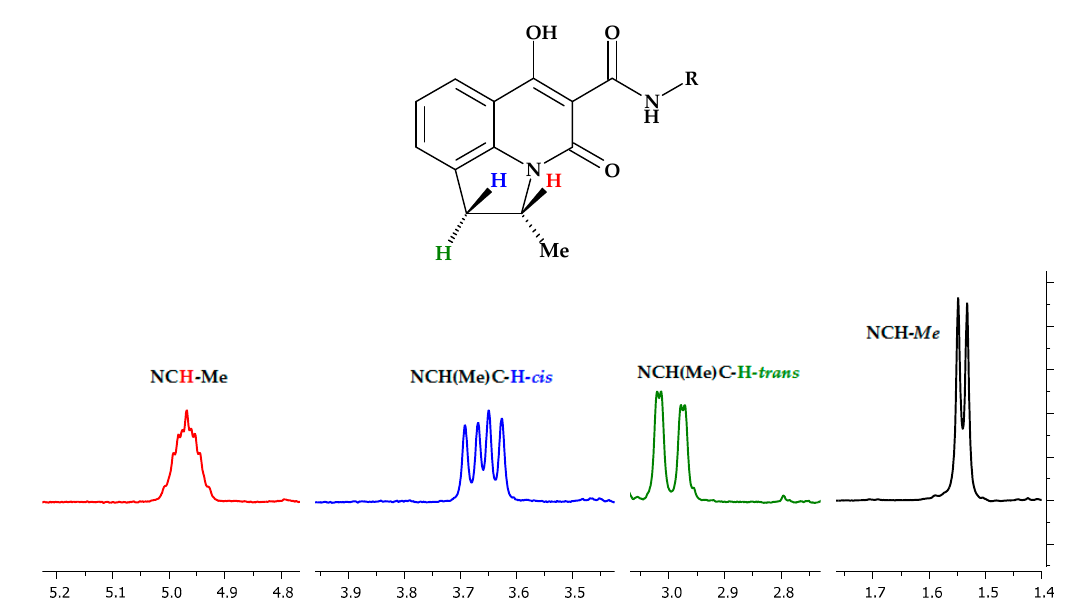
Figure 4. The fragment of the 1 H-NMR spectrum (the signals of 2-methylpyrroline protons) of benzylamide 2a .